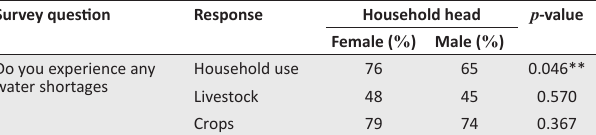
TABLE 2: Perceptions on water